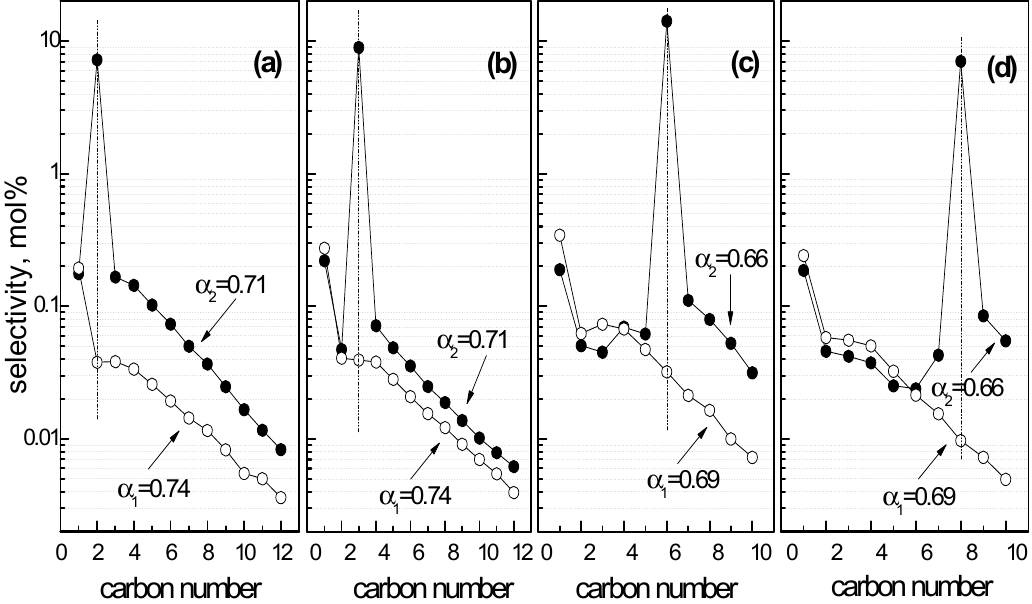
Figure 7. The effects of 1-alkene addition on FTS product distribution. ( a ) C 2 H 4 addition (T = 533 K, p = 1.0 Mpa, H 2 /CO = 8, H 2 /C 2 H 4 = 4). ( b ) C 3 H 6 addition (T = 533 K, p = 0.8 Mpa, H 2 /CO = 12, H 2 /C 3 H 6 = 5.6). ( c ) C 6 H 12 addition (T = 533 K, p = 0.8 Mpa, H 2 /CO = 5.4, H 2 /C 6 H 12 = 2.6). ( d ) C 8 H 16 addition (T = 533 K, p = 0.8 Mpa, H 2 /CO = 5.4, H 2 /C 8 H 16 = 5.1). (– ● –) and (–o–) are the total hydrocarbon distributions with and without alkene addition, respectively.